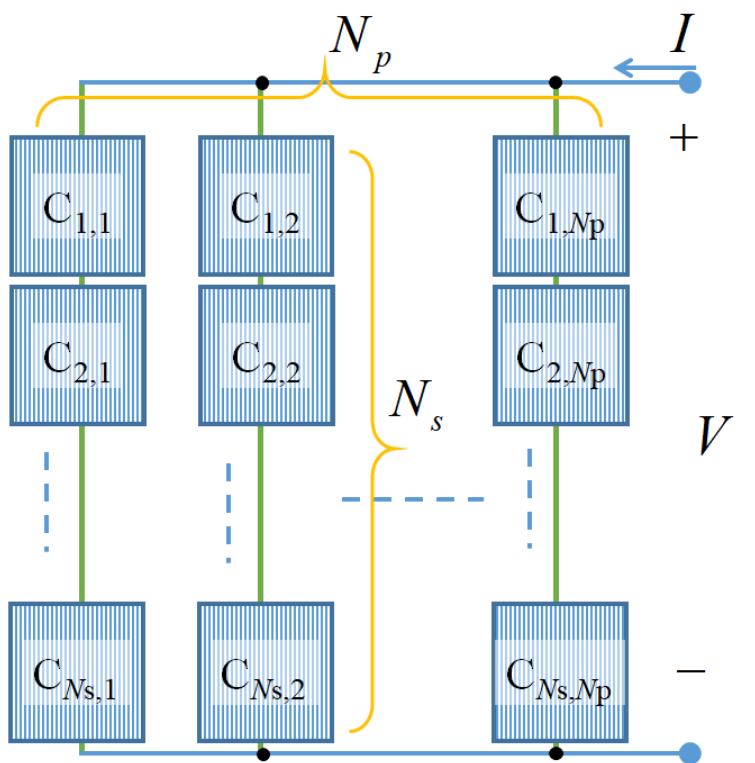
Figure 1. PV module comprising N s series-connected cells and N p parallel-connected